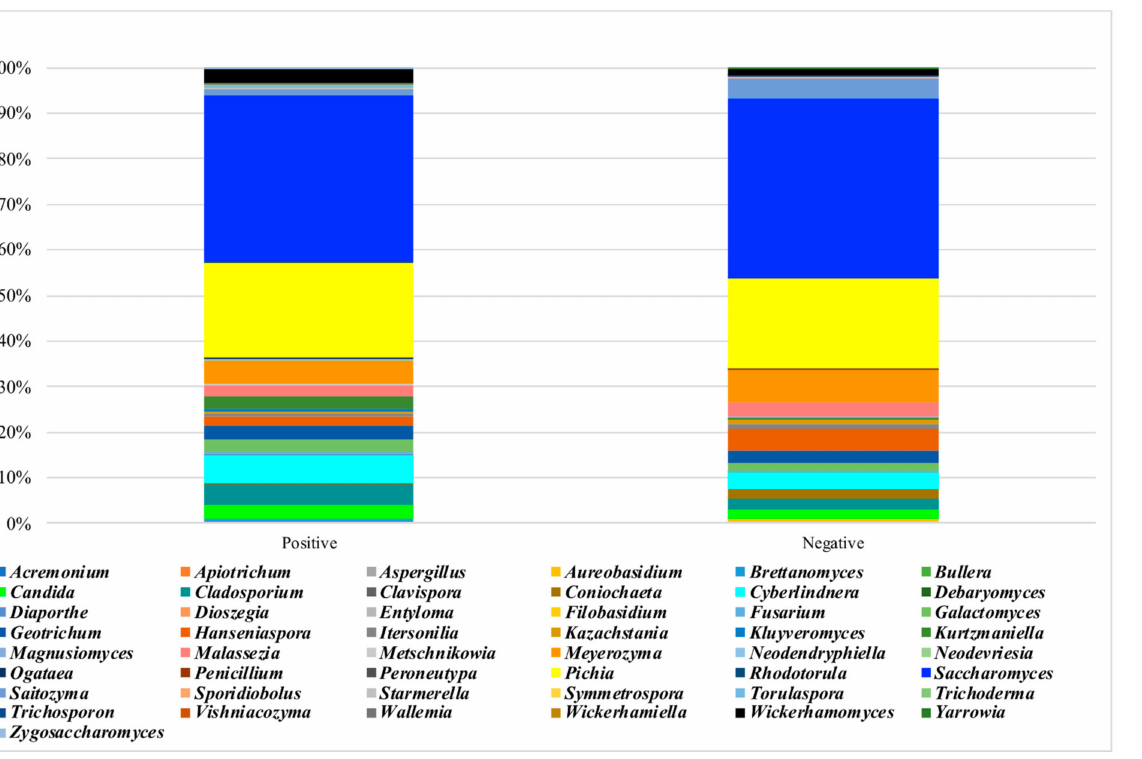
Figure 5. Mean frequency of ASV mycobiota composition by response to the DBPC gluten challenge